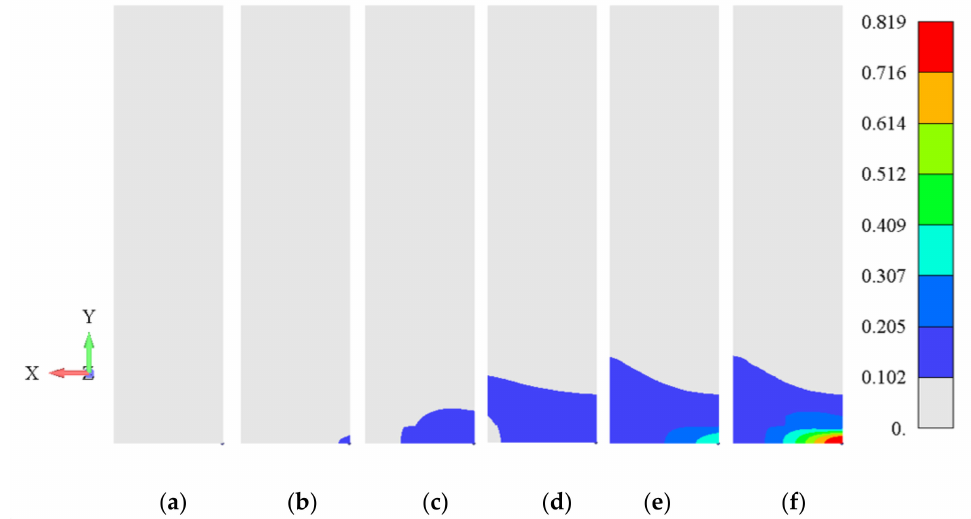
Figure 10. Damage phase-field, d , propagation in the post-critical zone for the displacement of the specimen’s top surface of ( a ) 9.60 mm, ( b ) 9.64 mm, ( c ) 9.68 mm, ( d ) 9.72 mm, ( e ) 9.76 mm, and ( f ) 9.80